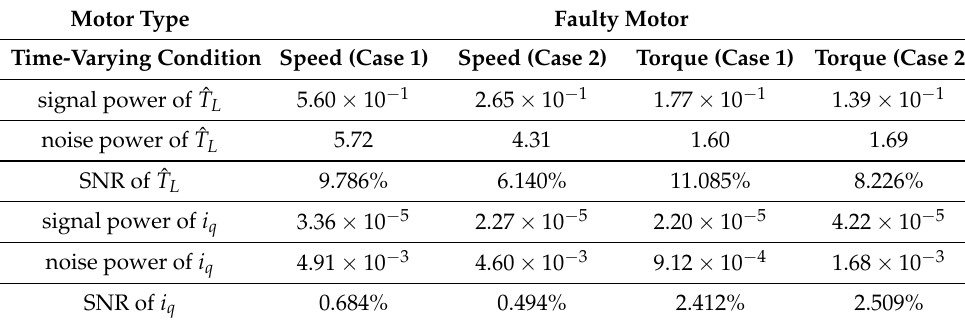
Table 2. The SNR of ˆ T L and i q in the faulty motor order spectra.